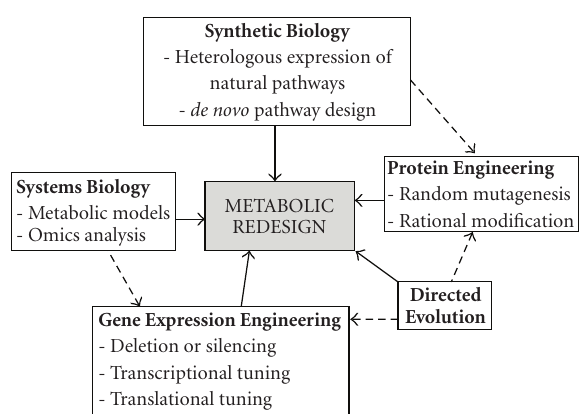
Figure 1: Overview of tools for metabolic